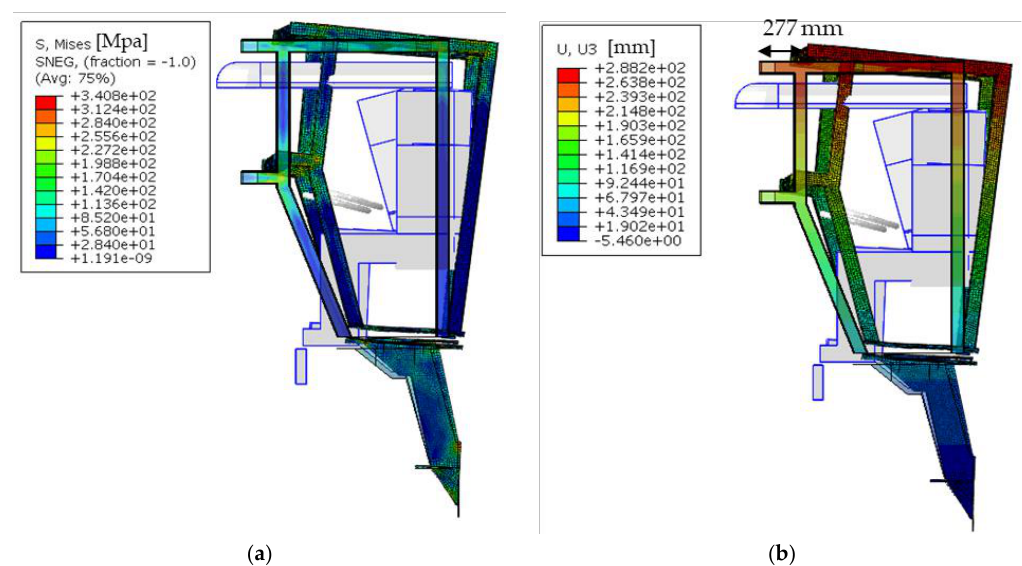
Figure 13. Longitudinal loading lateral view: ( a ) contour plot of Von Mises stress (expressed in MPa); ( b ) displacement contour plot (expressed in mm) attained at the maximum required energy.